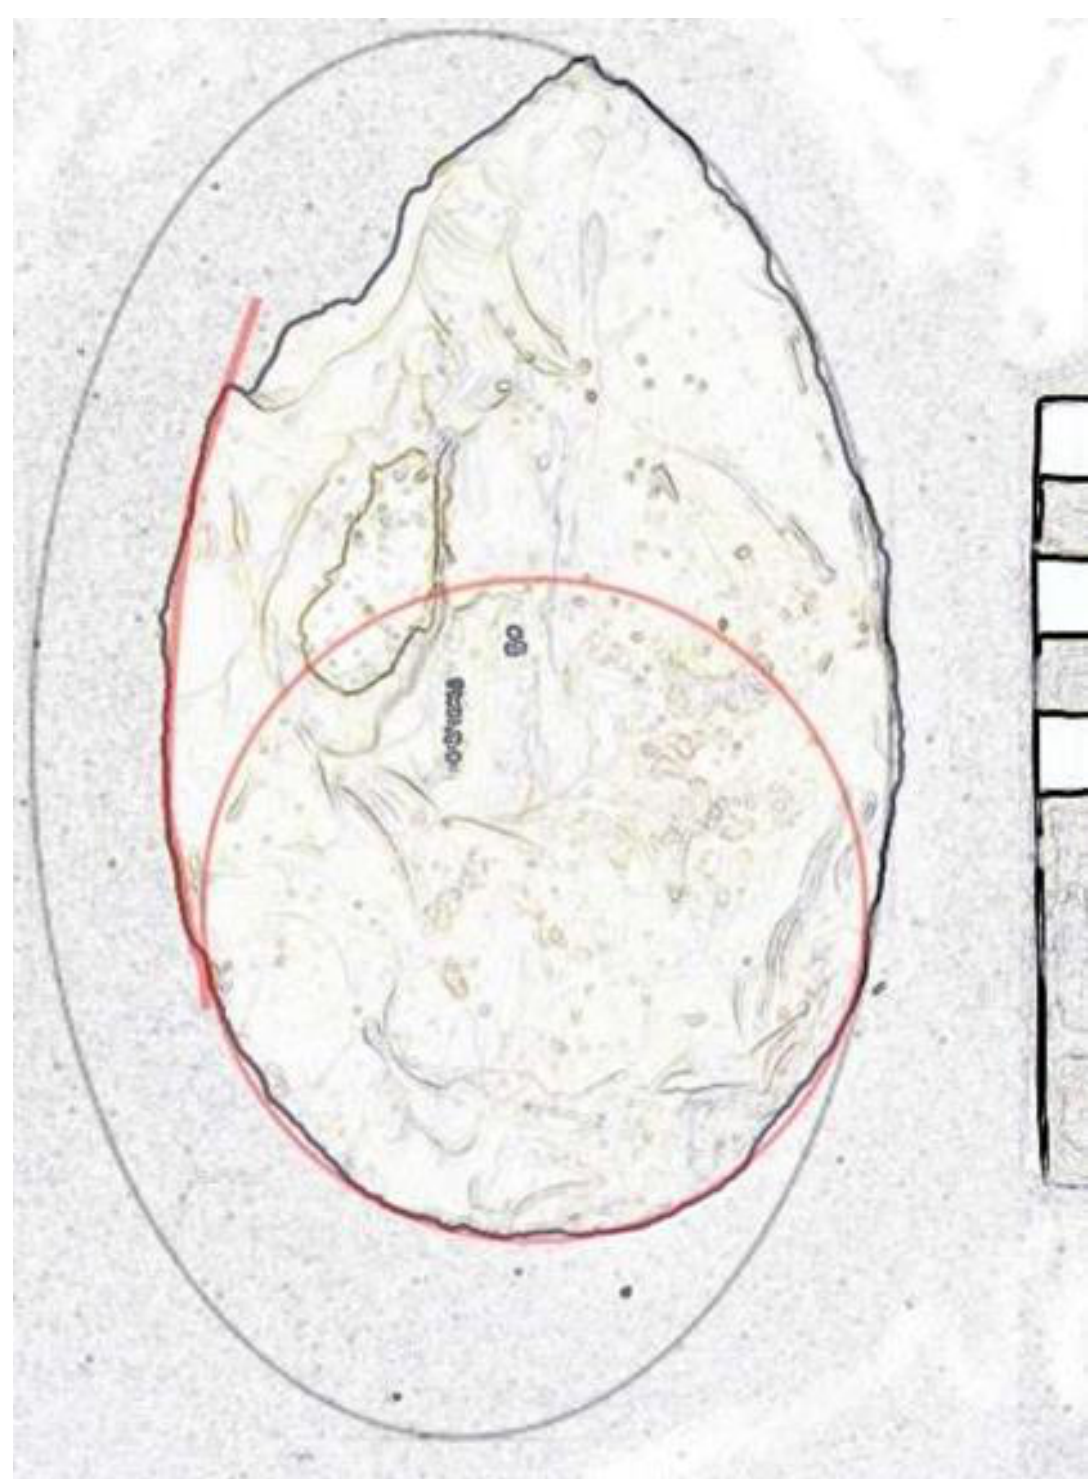
Figure 6. Specimen